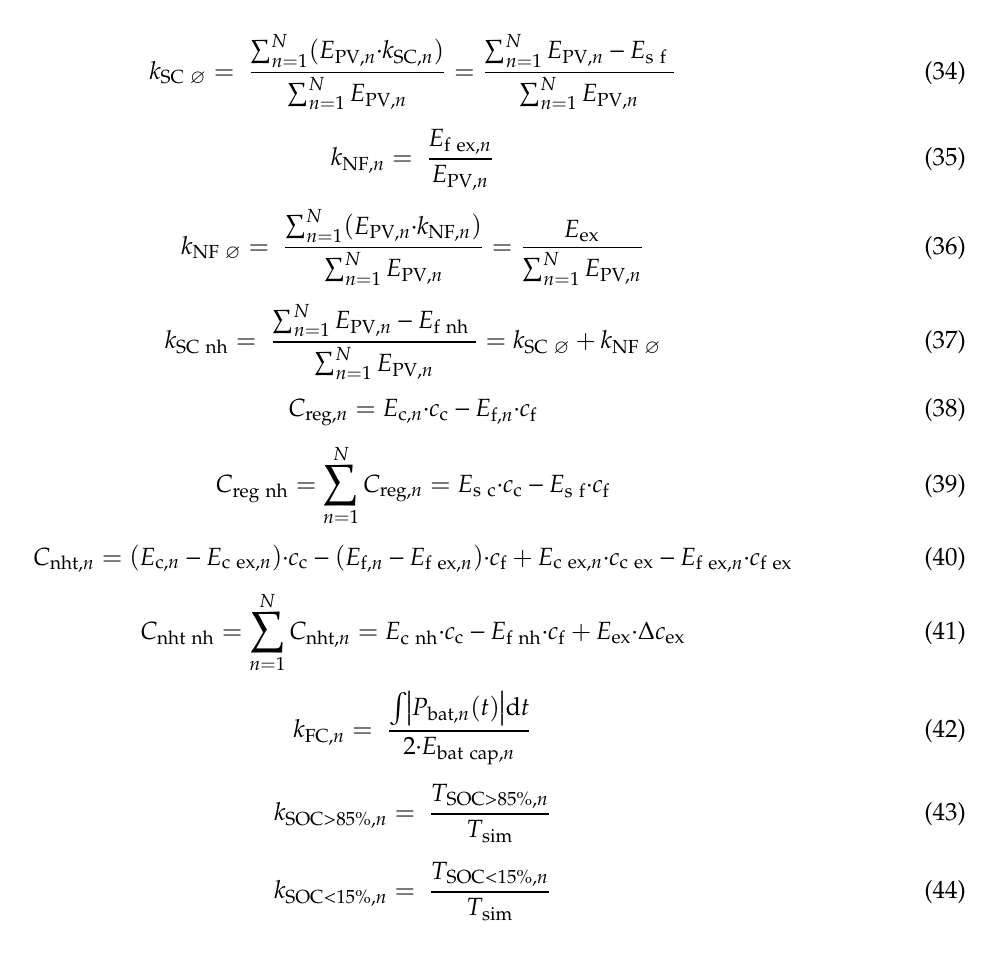
Table 3. Definitions of the evaluation